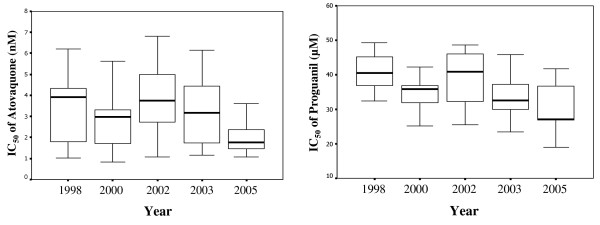
Box plots of atovaquone and proguanil IC50 of parasite isolates collected in different years.